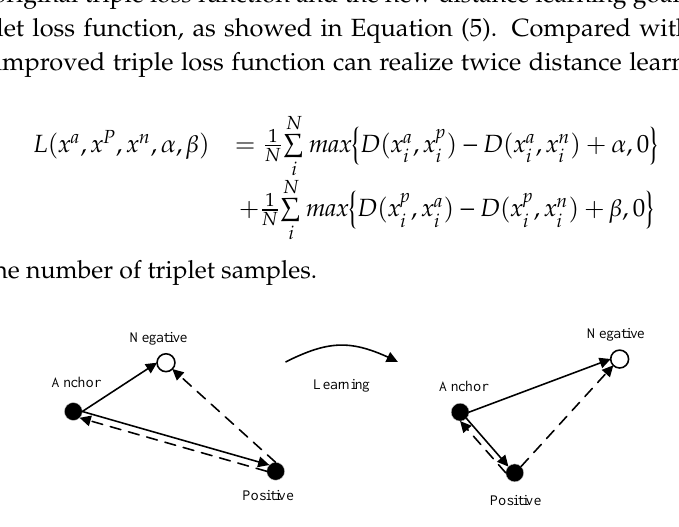
Figure 6. The improved learning goal of the triple network.